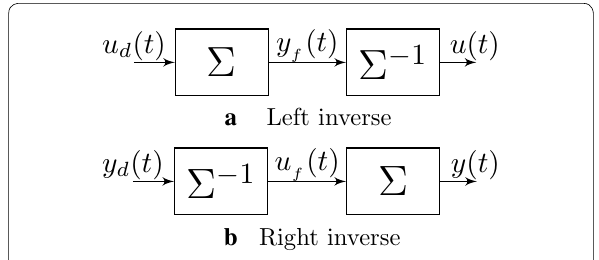
Fig. 1 Inverse controller configuration. Left inverse yields the input signal to the plant when excited from the knowledge of its output signal. Right inverse yields the necessary input to the plant for the desired plant